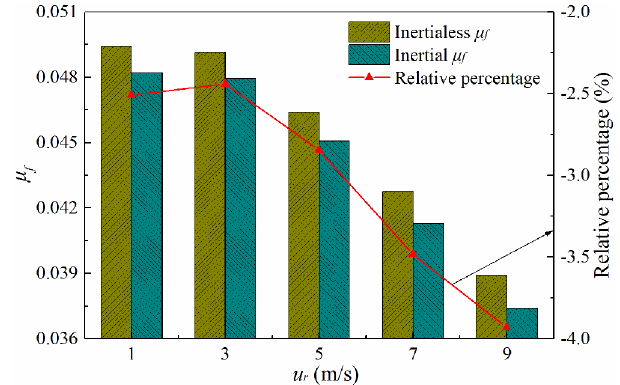
Fig. 13. Comparison between friction coef fi cient with and without inertia forces at varied applied entrainment